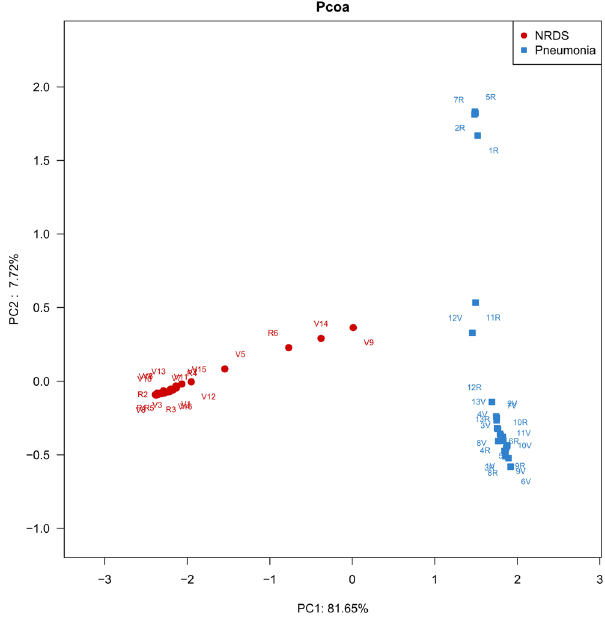
Figure 1. Principal coordinate analysis (PCoA) of the study samples based on the Bray-Curtis distance of bacteria communities. Samples collected from NRDS patients are represented by circles (red), including 17 with (V1–V17) and 6 without (R1–R6) ventilator-associated pneumonia (VAP) cases. Samples collected from pneumonia patients are represented by squares (blue), including 13 with (1V–13V) and 13 without (1R–13R) ventilator-associated pneumonia (VAP)